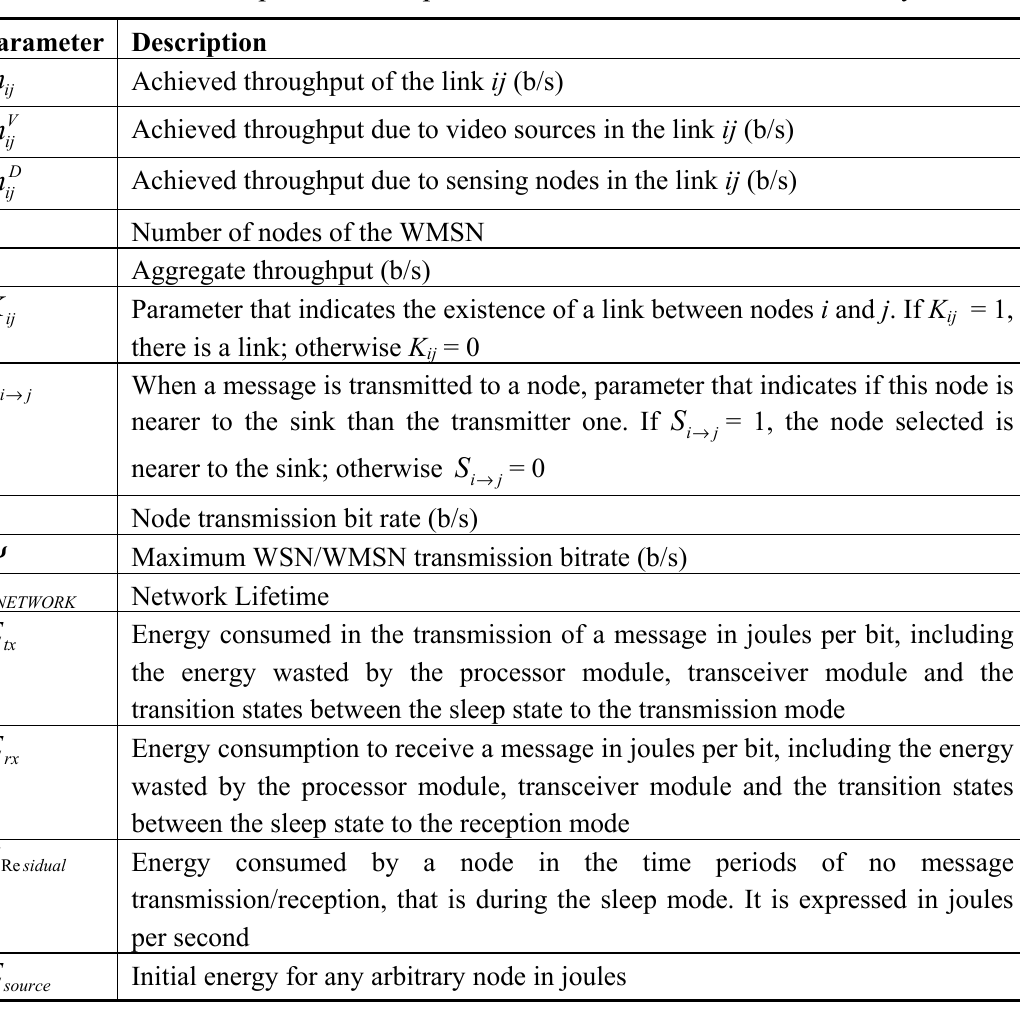
Table 1. Description of each parameter for the MO model under